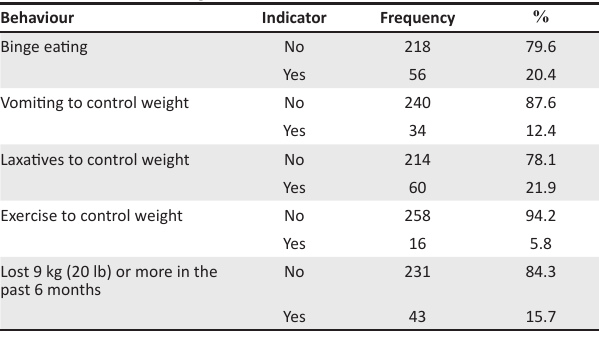
TABLE 3: Disordered eating behaviour. Behaviour